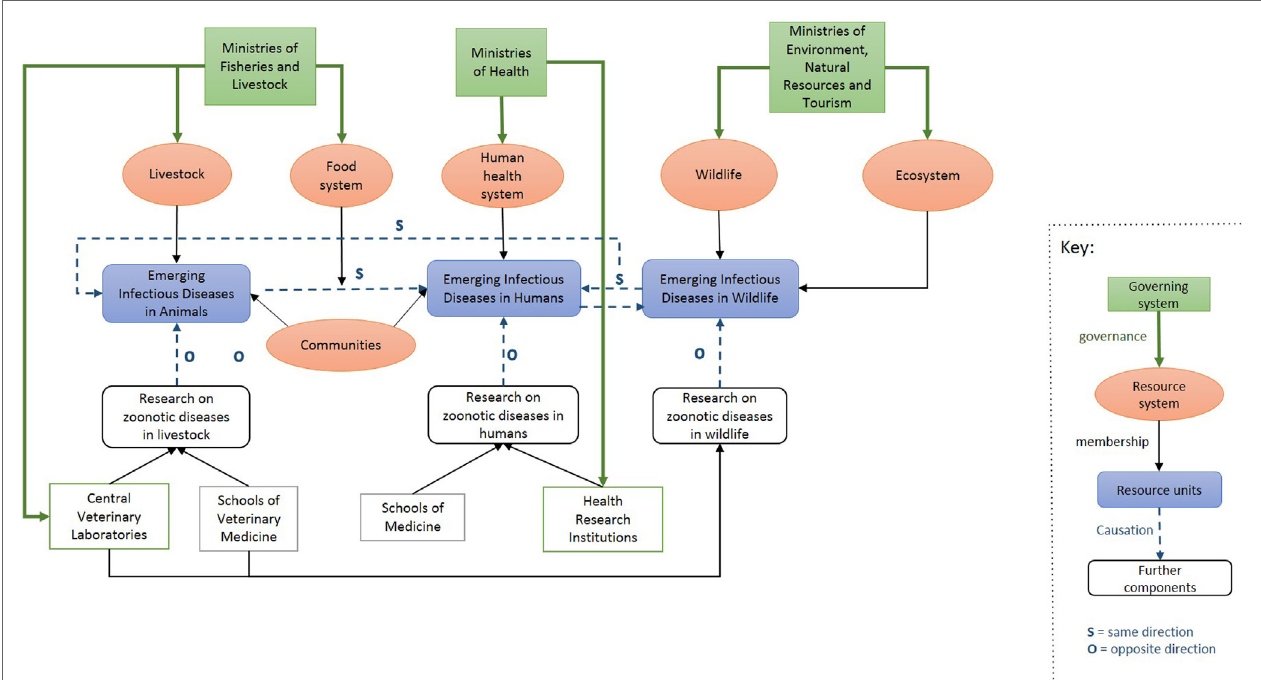
FigUre 1 | Overview of the context within which Southern African Centre for Infectious Disease Surveillance operates in Southern African countries.